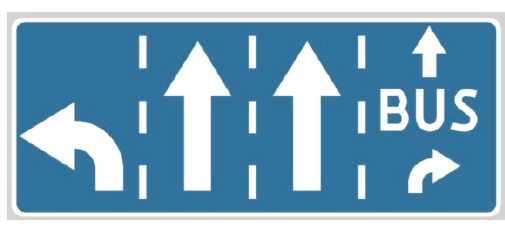
Figure 13. Supplementary sign F ‐ 10.